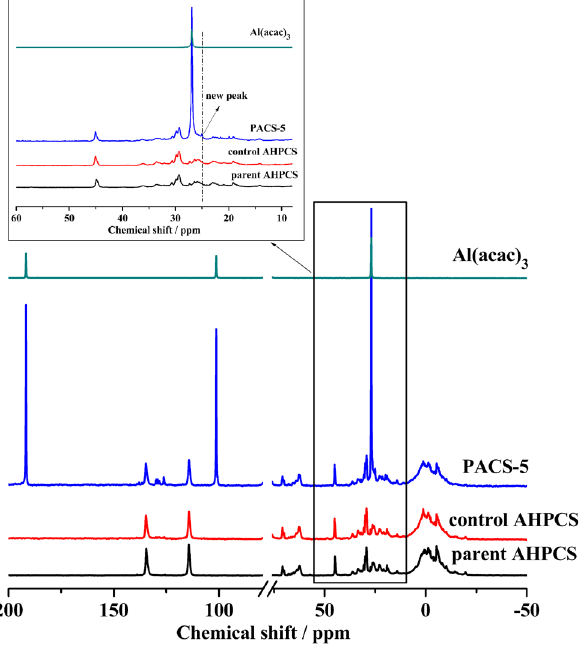
Figure 4: 13 C NMR spectra in CDCl 3 of parent AHPCS, control AHPCS, PACS - 5, and Al ( acac ) 3